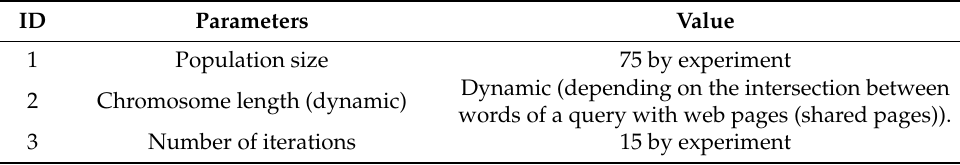
Table 8. Modified genetic algorithm parameters.